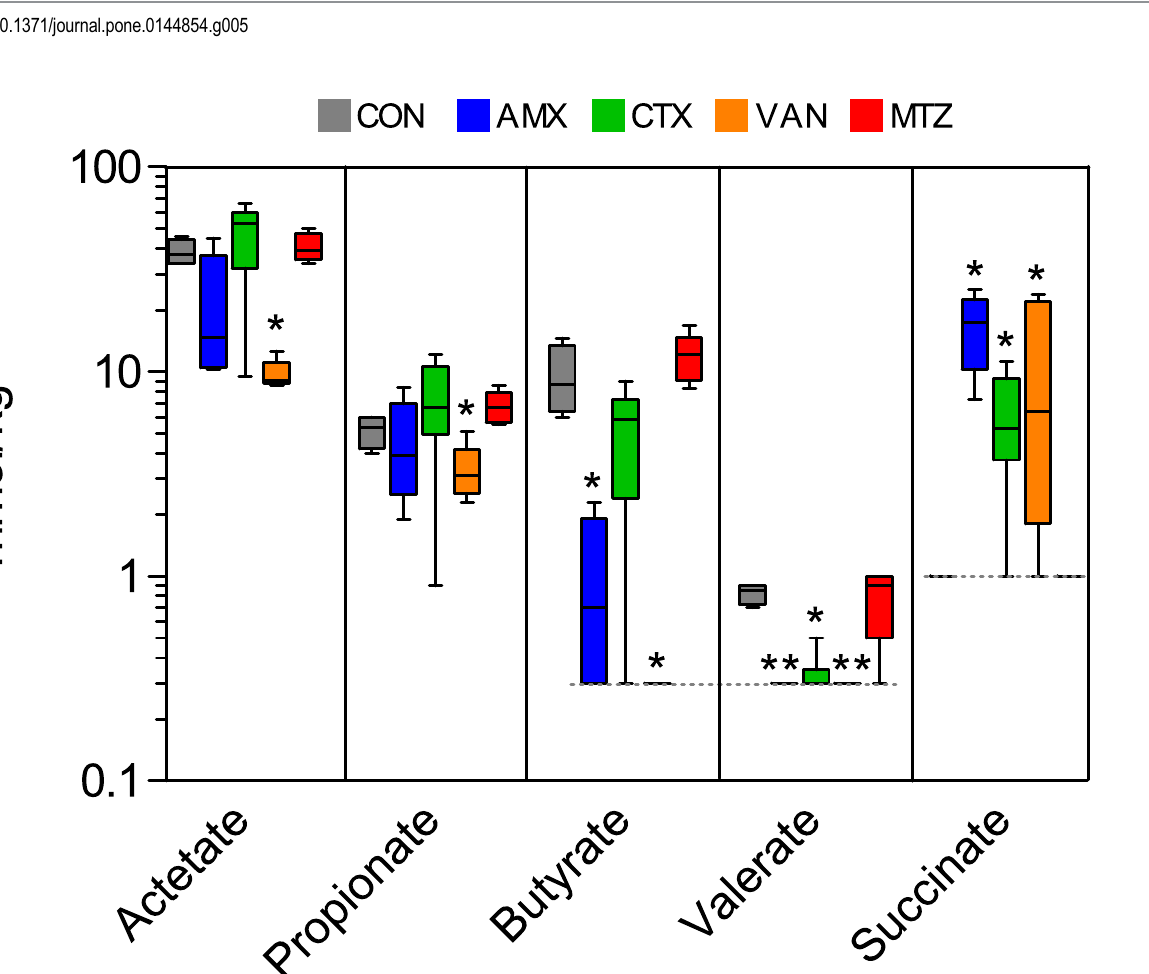
Fig 6. Short chain fatty acid and succinate. Concentrations of acetate, propionate, butyrate, valerate and succinate in caecum for each treatment group. Boxplots with whisker denoting the full range are shown. Control (grey), amoxicillin (blue), cefotaxime (green), vancomycin (yellow) and metronidazole (red). The dashed lines indicate limit of detection. Significant differences from CON group are indicated by asterisks ( * P < 0.05, ** P < 0.01).